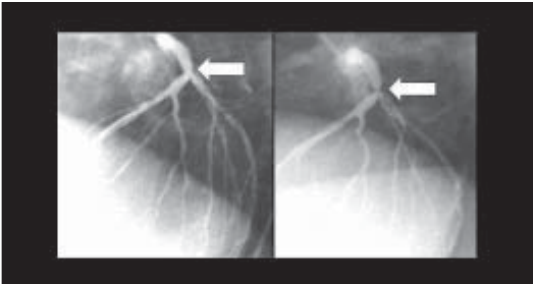
Fig. 3 - Development of left coronary artery branch injury 14 months after stent implantation in the anterior descending artery.